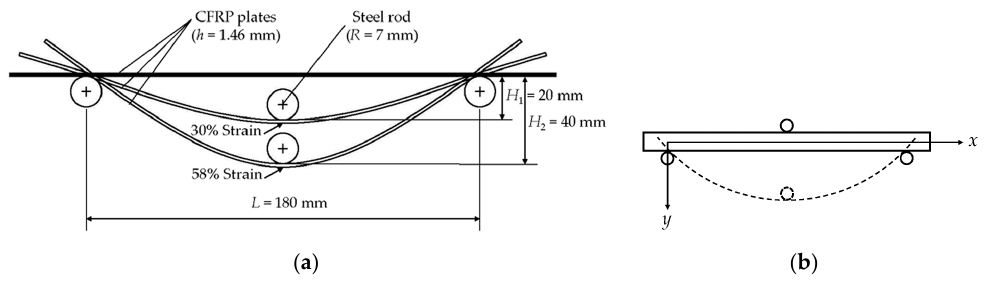
Figure 1. Steel fixture for sustained strain of carbon fiber reinforced polymer (CFRP) plates. ( a ) Schematic sketch, ( b ) the coordination system.